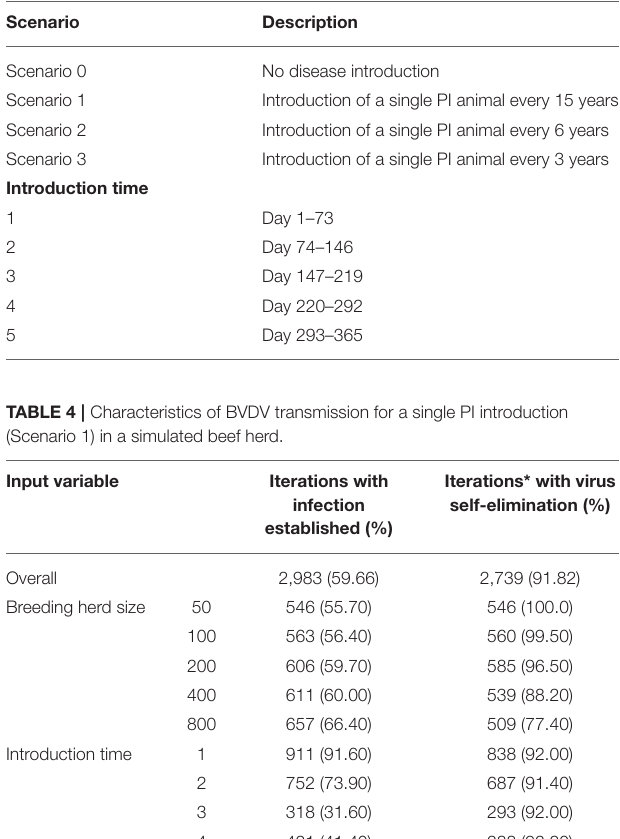
TABLE 3 | Scenario and introduction time categories for within-herd simulation of BVDV in an Australian beef herd.